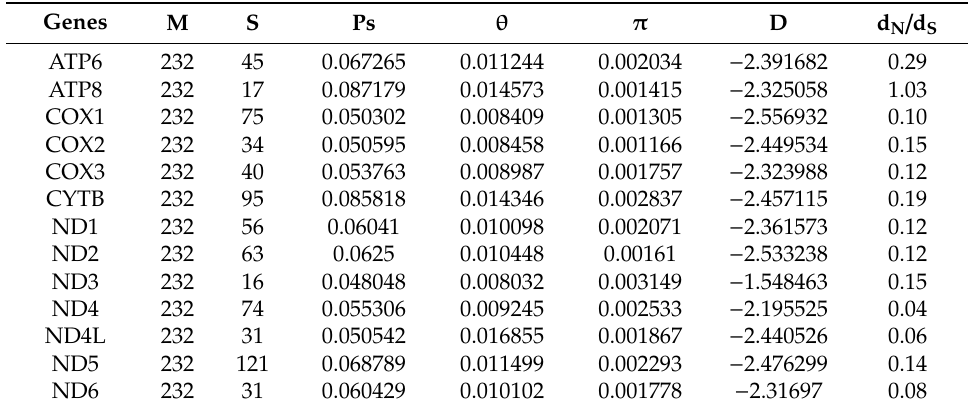
Table 2. Population genetic parameters and the ratio of nonsynonymous to synonymous substitution rate for each mitochondrial gene.